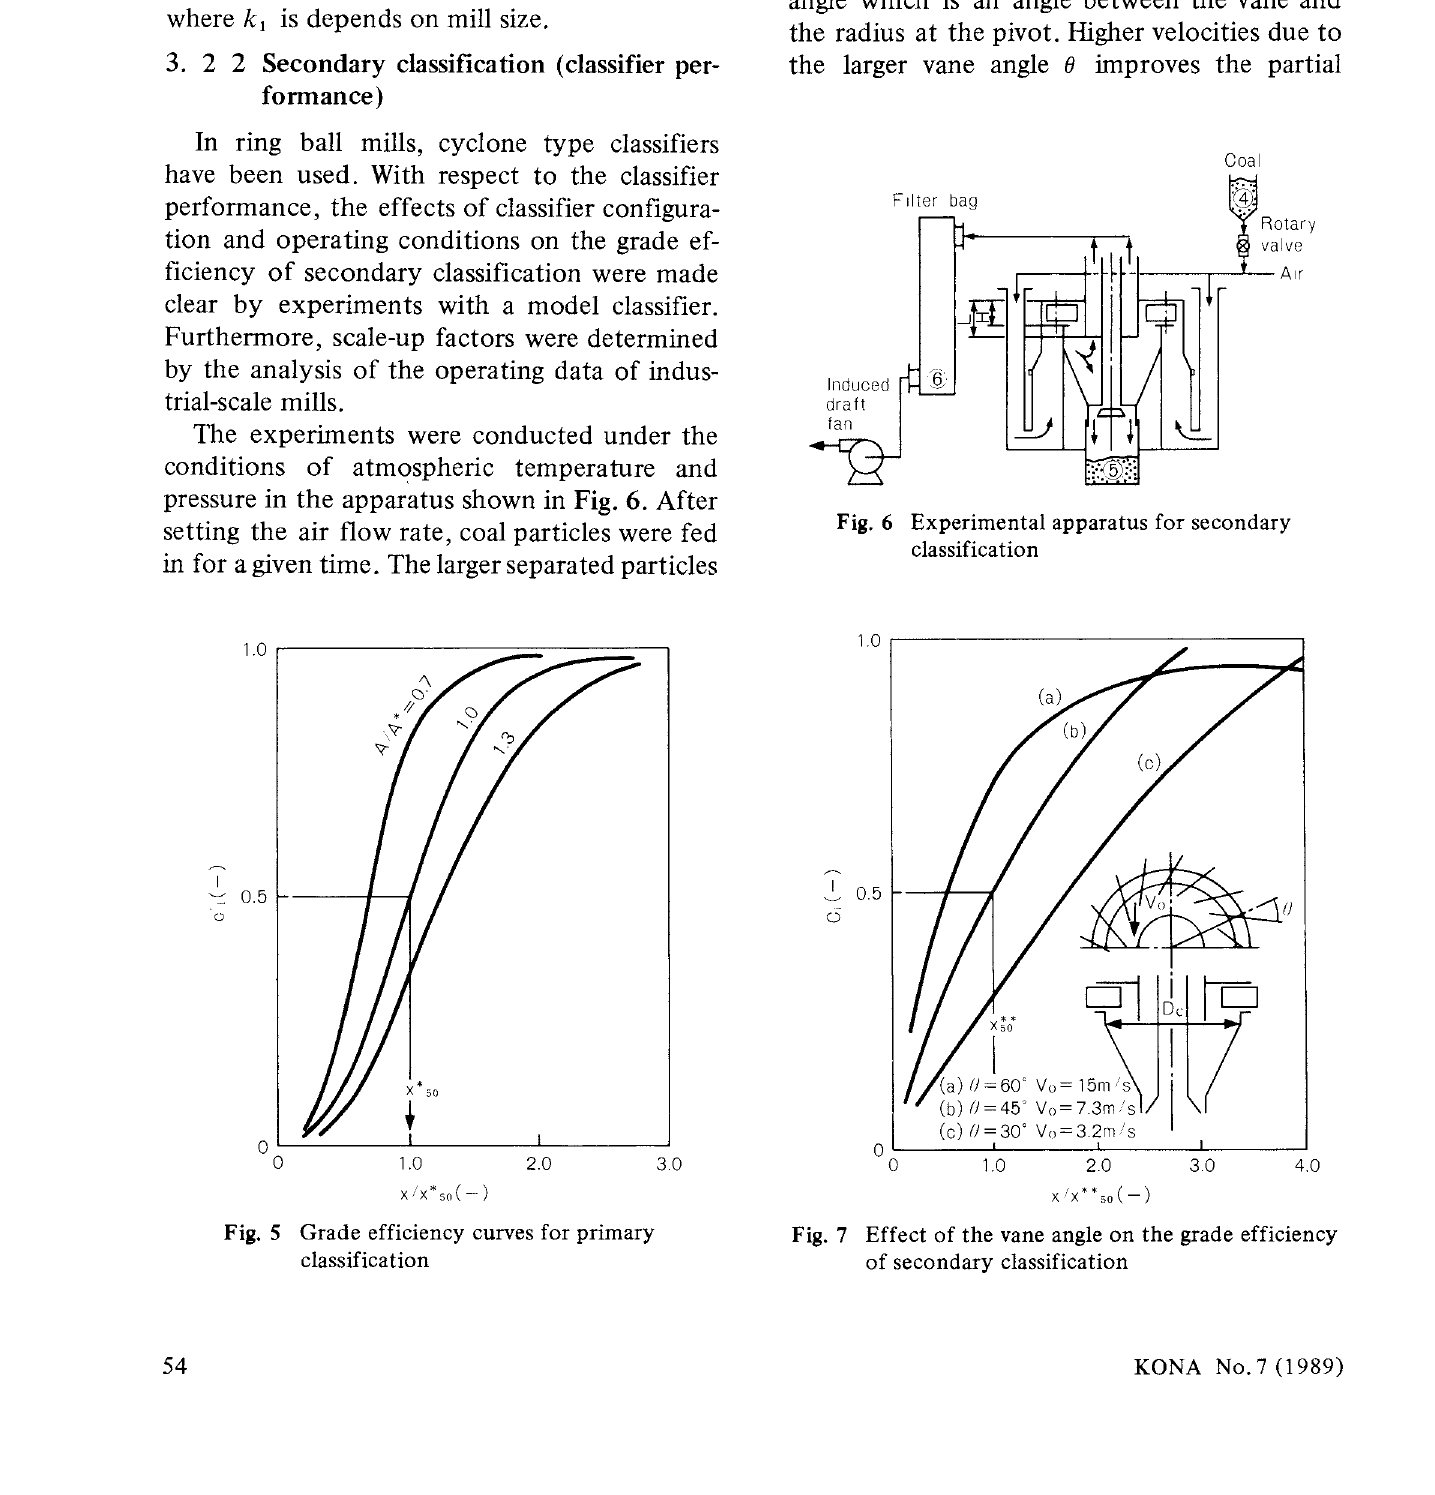
Fig. 7 Effect of the vane angle on the grade efficiency of secondary